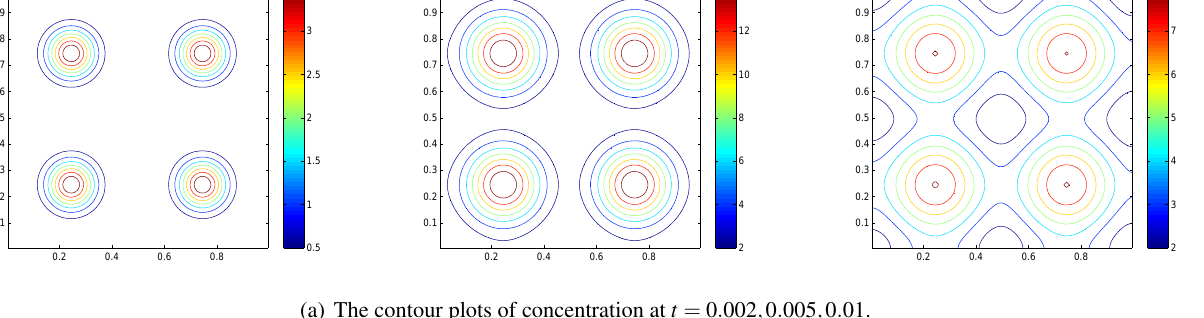
(a) The contour plots of concentration at t = 0 . 002 , 0 . 005 , 0 . 01.